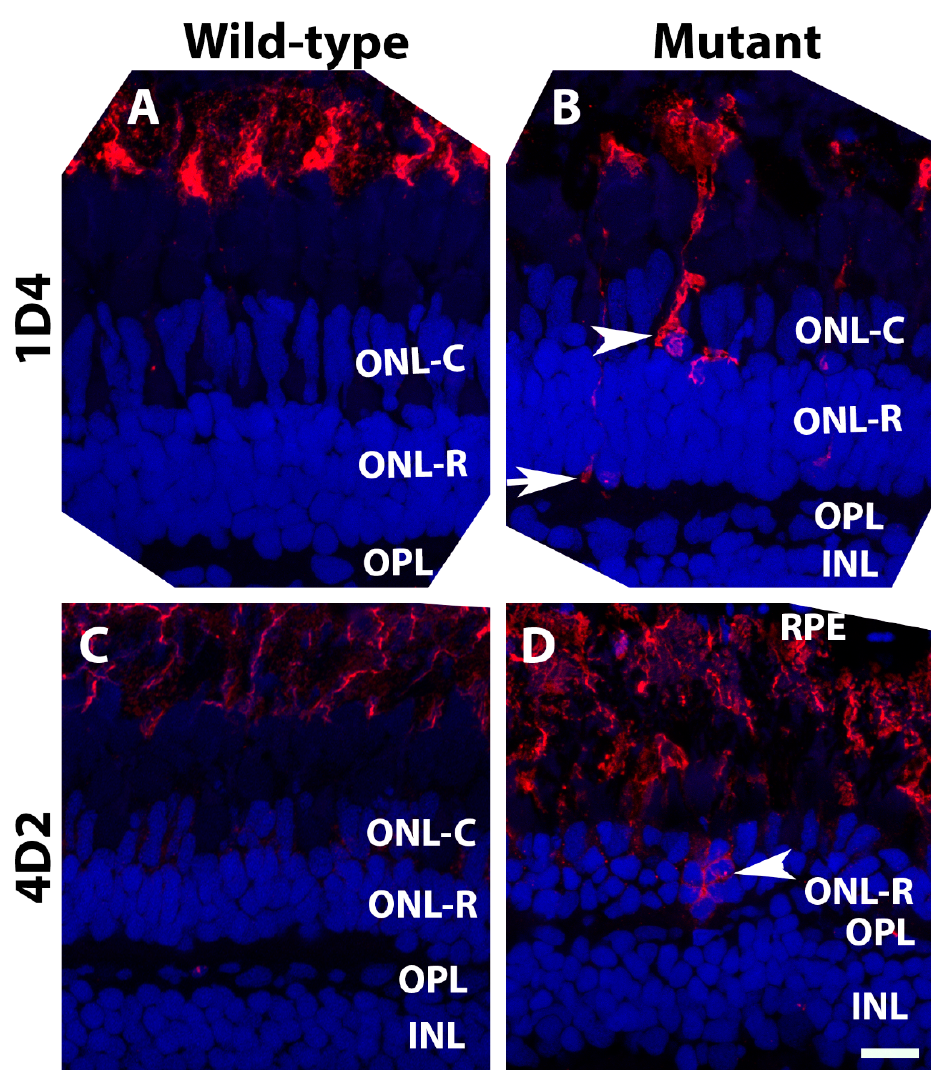
Figure 5. Opsin mis-localization was found in pomt2 mutant retinas. Retinal sections from zebrafish at 6-mpf were immunostained with antibodies 1D4 and 4D2 (red fluorescence) and counter-stained with DAPI (blue) ( n = 3). ( A ) 1D4 immunostaining of a wild-type retina at 6-mpf. ( B ) 1D4 immunostaining of a homozygous pomt2 sny5+13 mutant retina at 6-mpf. Note the presence of strongly 1D4-stained cell bodies (arrowhead) and terminals (arrow). ( C ) 4D2 immunostaining of a wild-type retina at 6-mpf. ( D ) 4D2 immunostaining of a homozygous pomt2 sny5+13 mutant retina at 6-mpf. Note strongly 4D2 fluorescent cell bodies in the ONL. Scale bar in ( D ): 10 µ